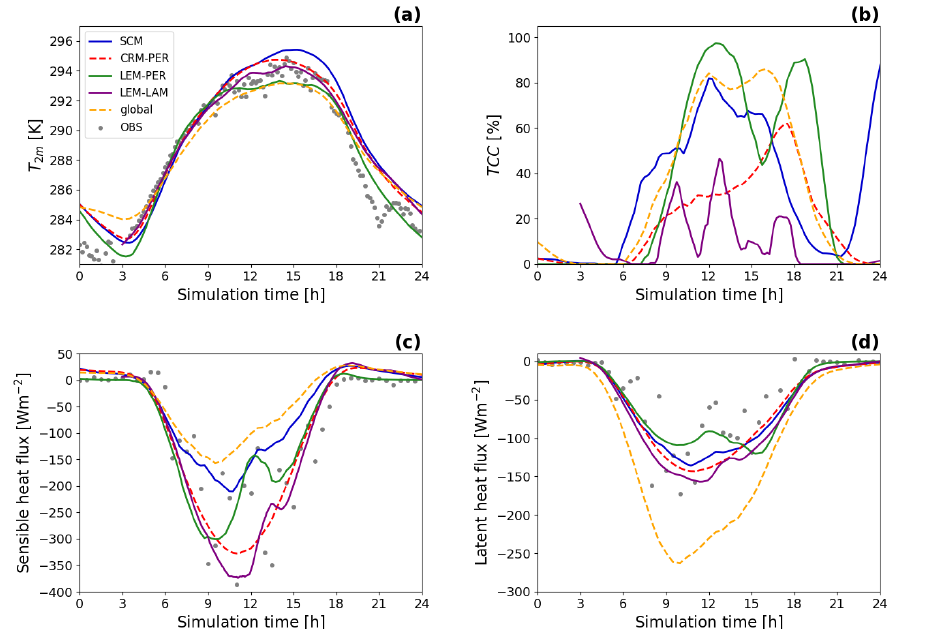
Figure 12. Time series of ( a ) 2 m temperature ( T 2 m ), ( b ) total cloud cover (TCC), ( c ) surface downward sensible heat flux, and ( d ) surface downward latent heat flux for the FESSTVaL field experiment at Lindenberg starting from 12 July 2020 00UTC. Comparison between ICON simulations: the SCM/LEM-PER/CRM-PER on a torus grid, the global ICON (global), the LEM on a LAM grid (LEM-LAM), and observations at the Falkenberg site